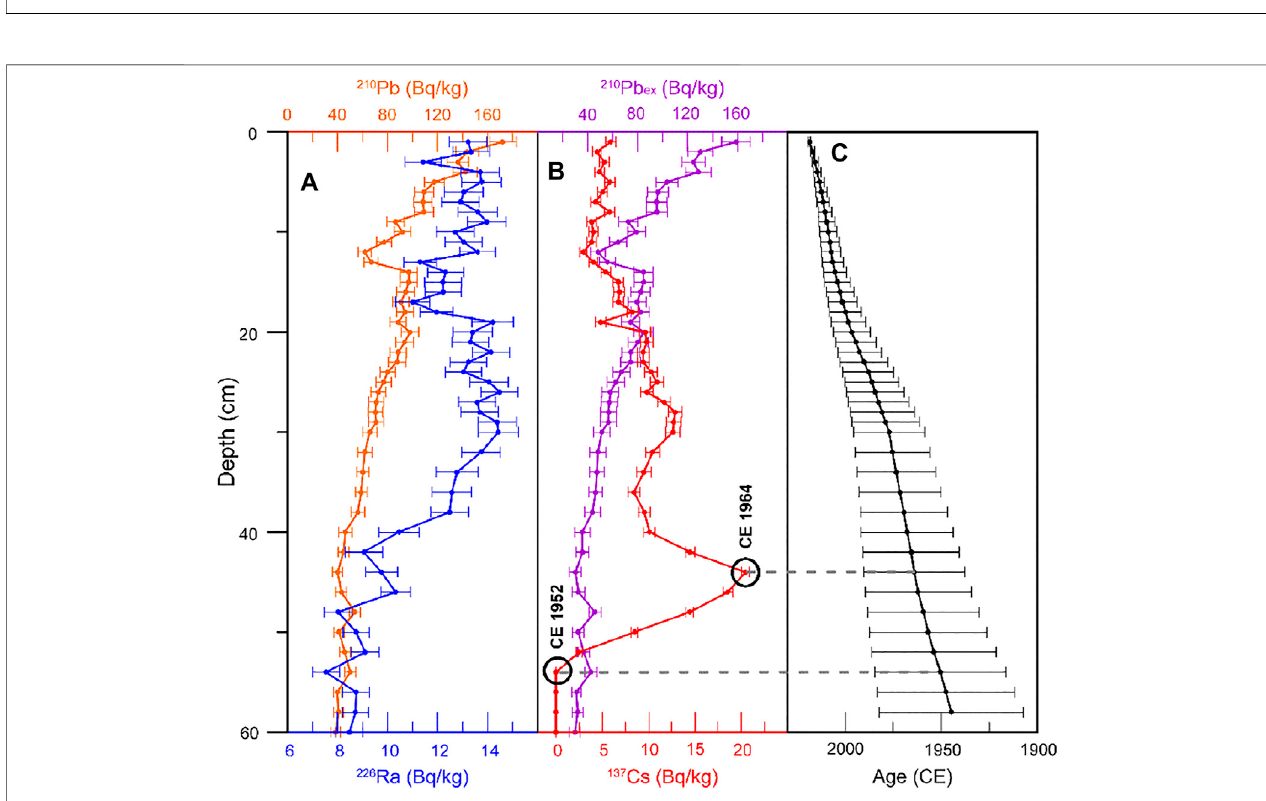
FIGURE2 | Age – depth model for DH20B based on radionuclidedating results. (A) Stratigraphic plots of 210 Pb and 226 Rain becquerelsper kilogram (Bq/kg) dried sediment. (B) Stratigraphic plots of 210 Pb ex and 137 Cs in Bq/kg dried sediment. (C) Age model for DH20B is based on the CRS model (Appleby, 2001).